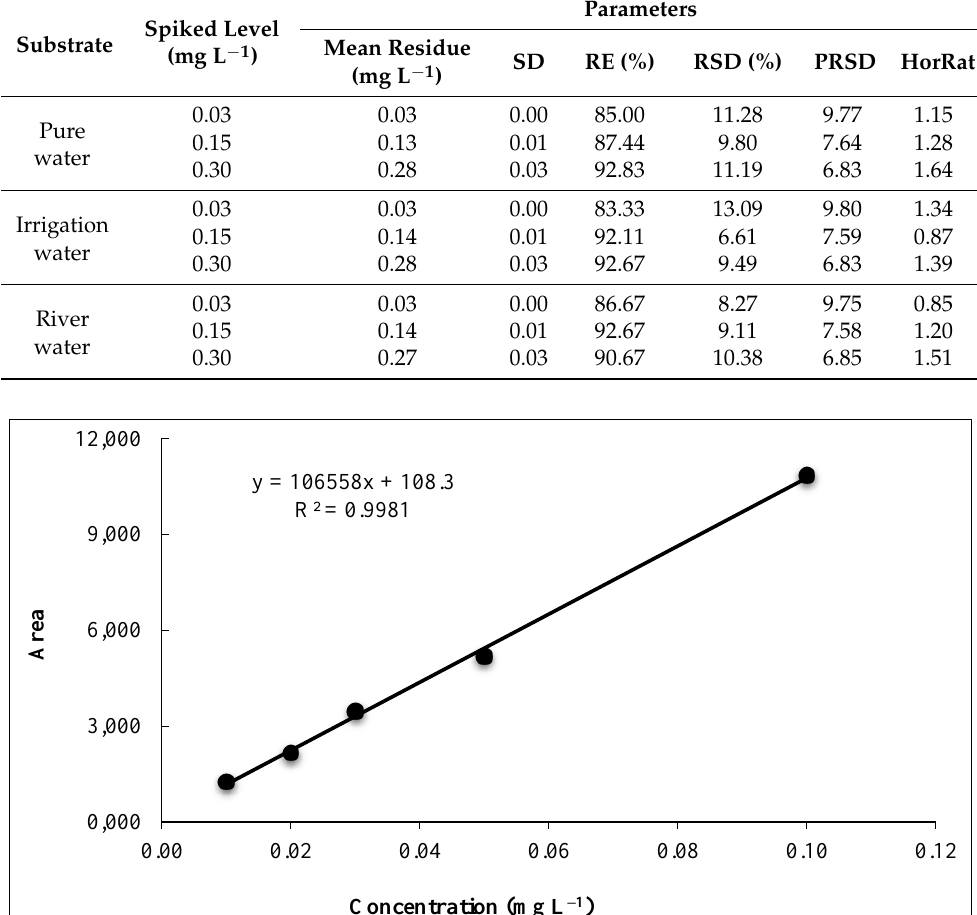
Figure 2. Calibration curve of flucetosulfuron.